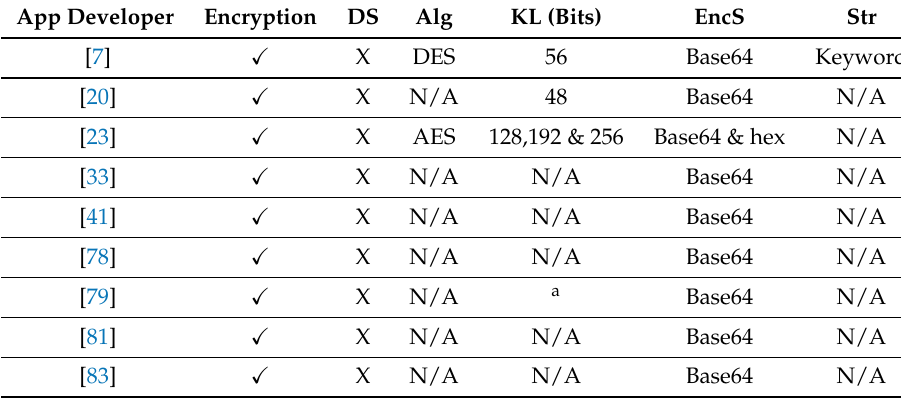
Table 3. Crypto-based QR Code Scanners.